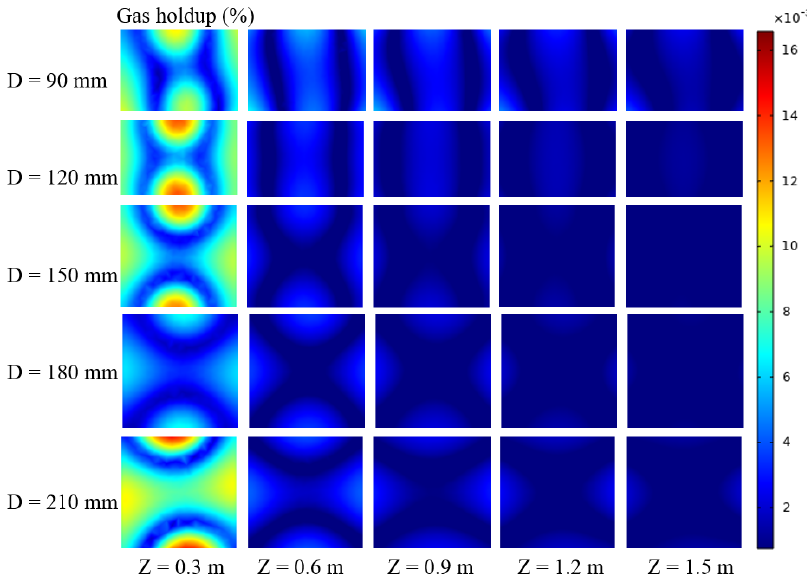
Figure 17. Cloud map of the gas holdup variation along the horizontal direction at different orifice spacings.